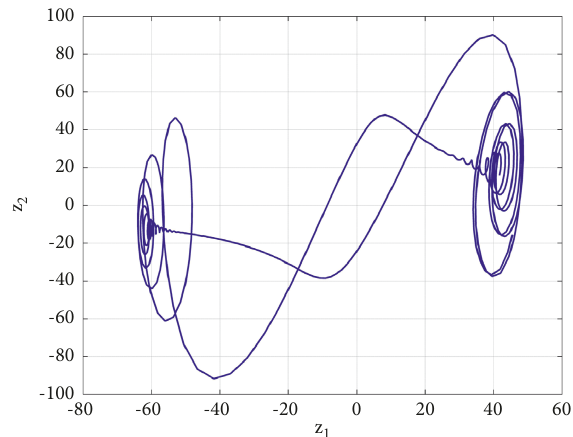
Figure 4: A periodic response of the model (1) for a � 6 and ( b, c, d ) � ( 8 , 90 , 6 ) .